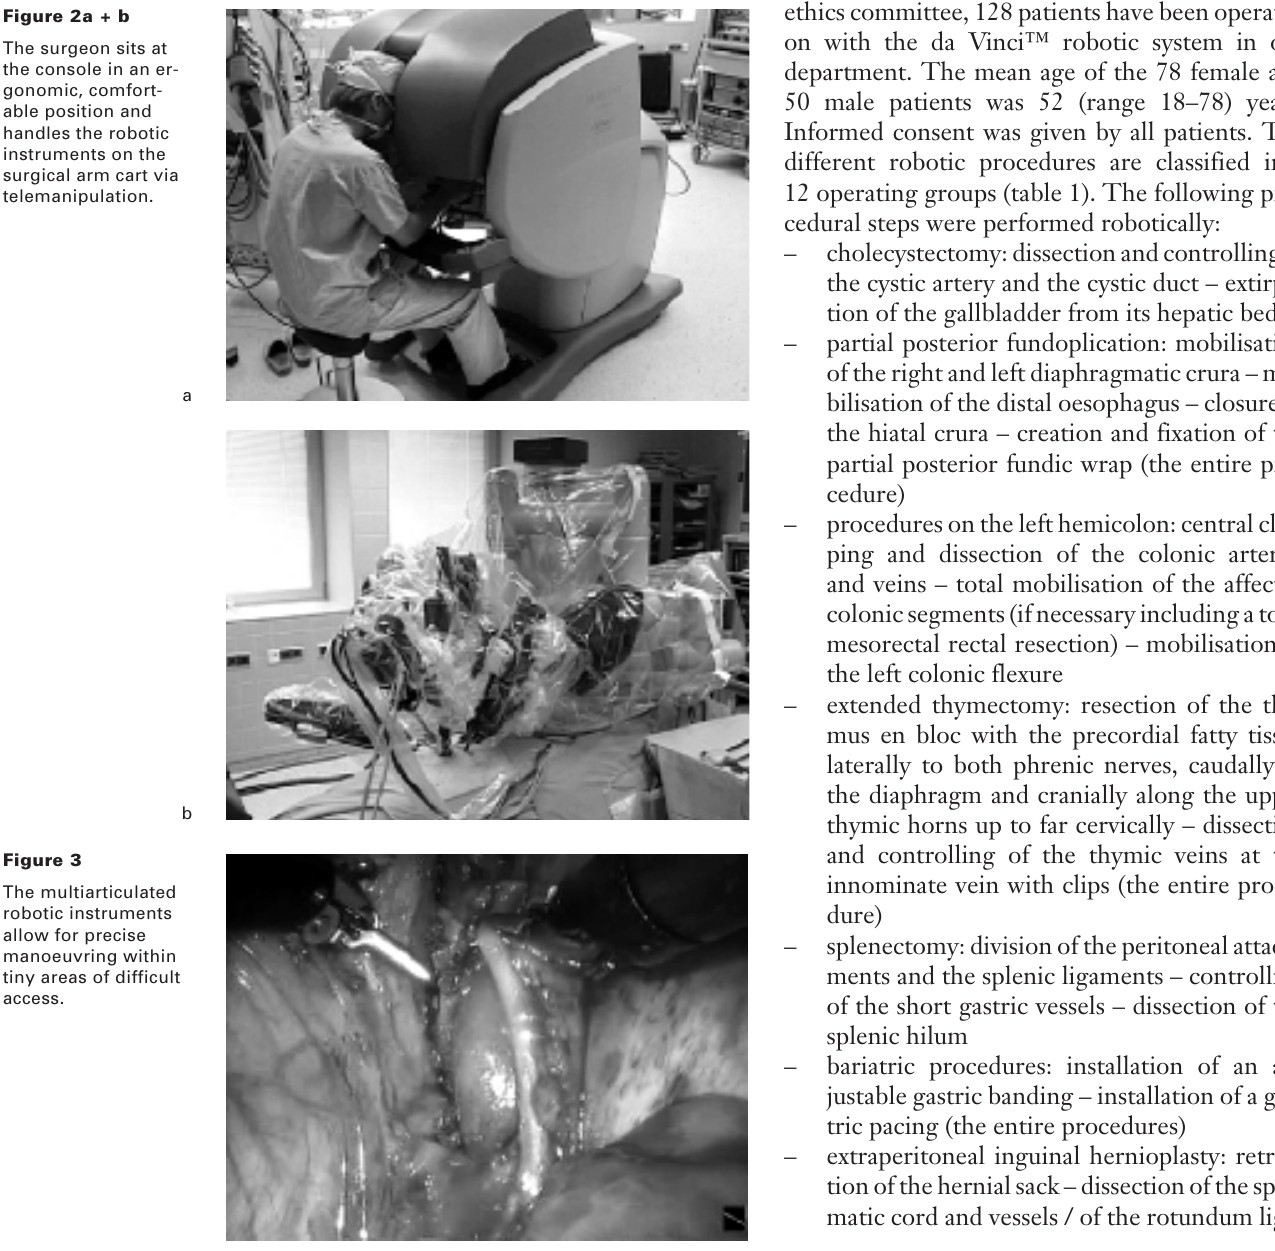
Figure 2a + b The surgeon sits at the console in an er- gonomic, comfort- able position and handles the robotic instruments on the surgical arm cart via telemanipulation.